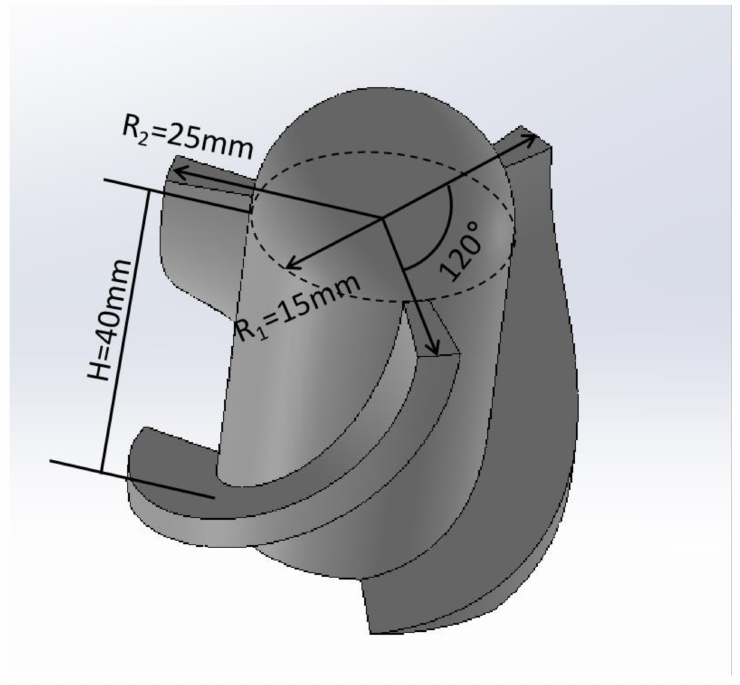
Figure 2. Three-dimensional vane model.